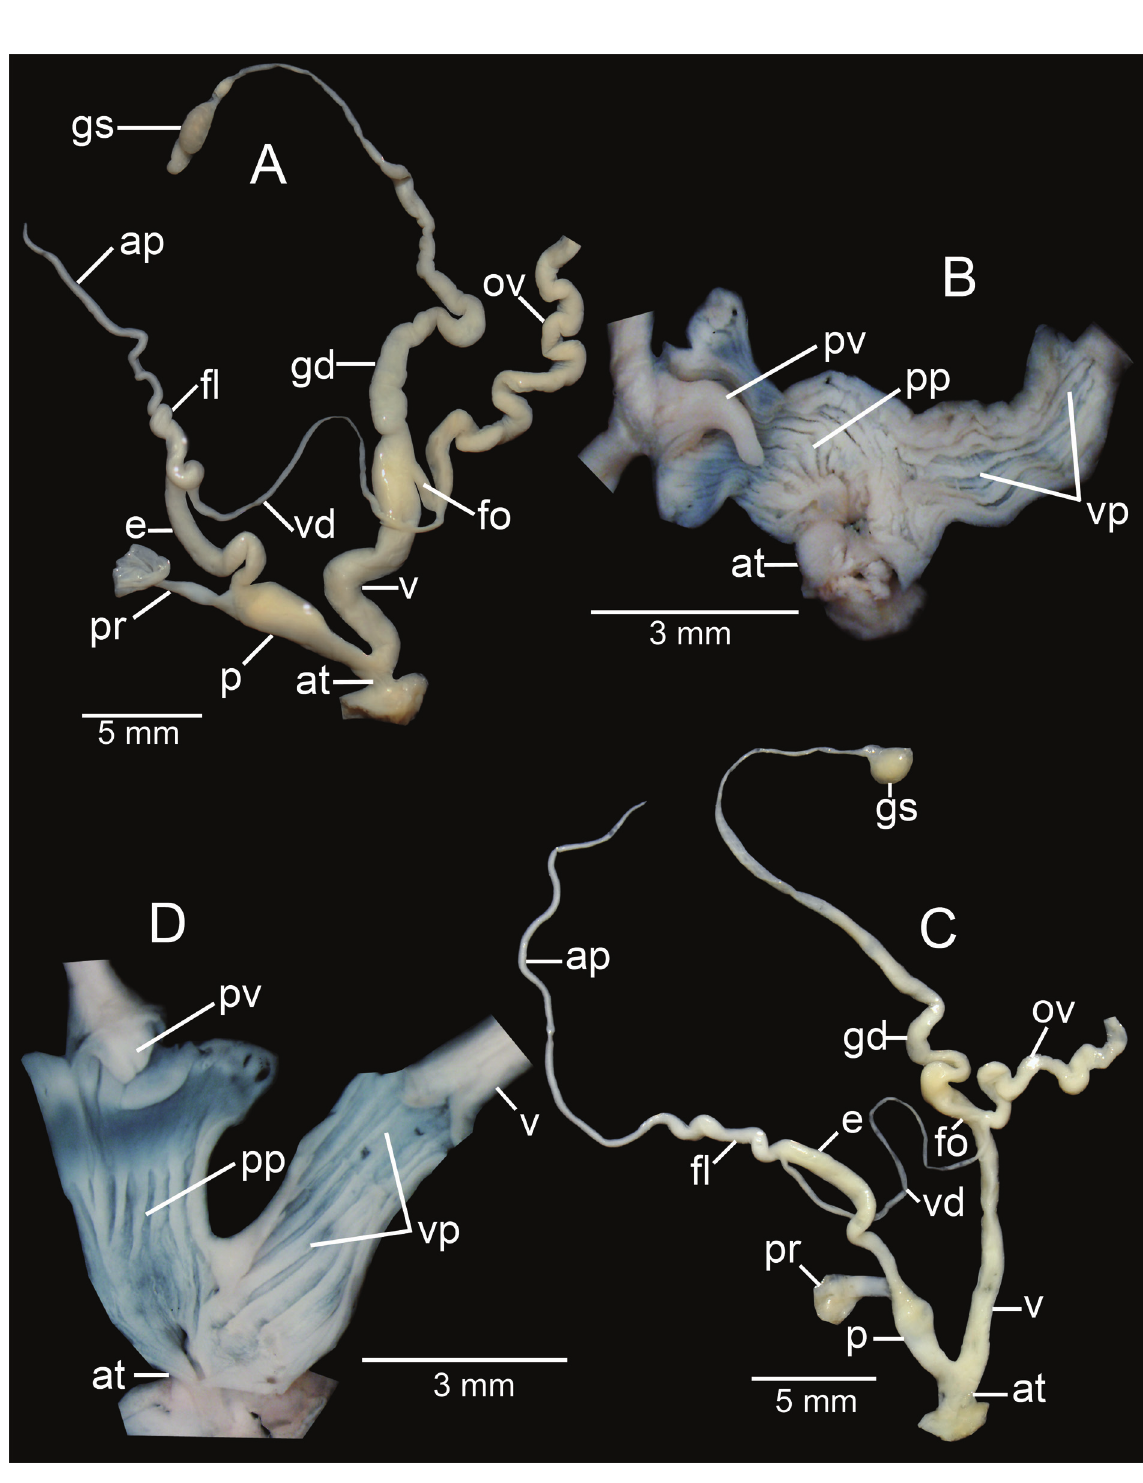
Fig. 6. Genitalia of Amphidromus spp. A–B . Amphidromus roseolabiatus Fulton, 1896 from Ban Phavong, Khammouan, Laos showing reproductive system and interior structures of penis and vaginal chamber (CUMZ 7012). C–D . Amphidromus syndromoideus sp. nov., holotype, showing general characteristics of the genital system and interior structures of penis and vagina chamber (CUMZ